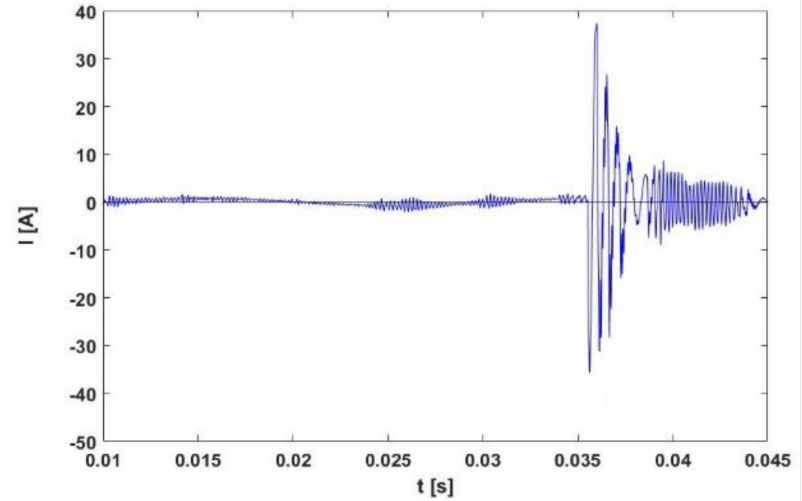
Figure 10. Input current waveform in the microinverter section disturbed by voltage surge with negative polarization.